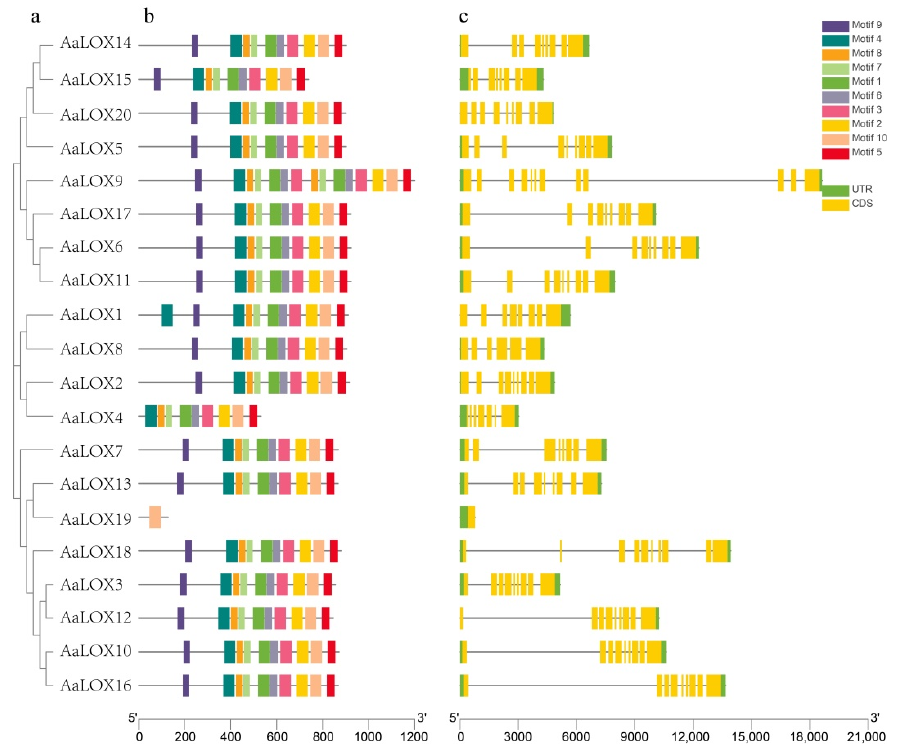
Figure 3. Gene structure and conserved motif of AaLOX genes. ( a ) Phylogenetic tree. Neighbor-joining (NJ) tree was constructed using MEGA X. ( b ) Conserved motif. The colored boxes on the right denote 10 motifs. ( c ) Gene structure. The yellow boxes, black lines, and green boxes represent exon, intron, and untranslated region (UTR), respectively.